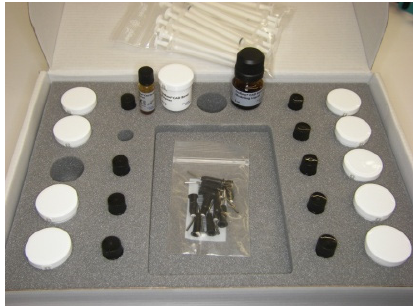
Figure 20. Digital denture teeth bonding kit.